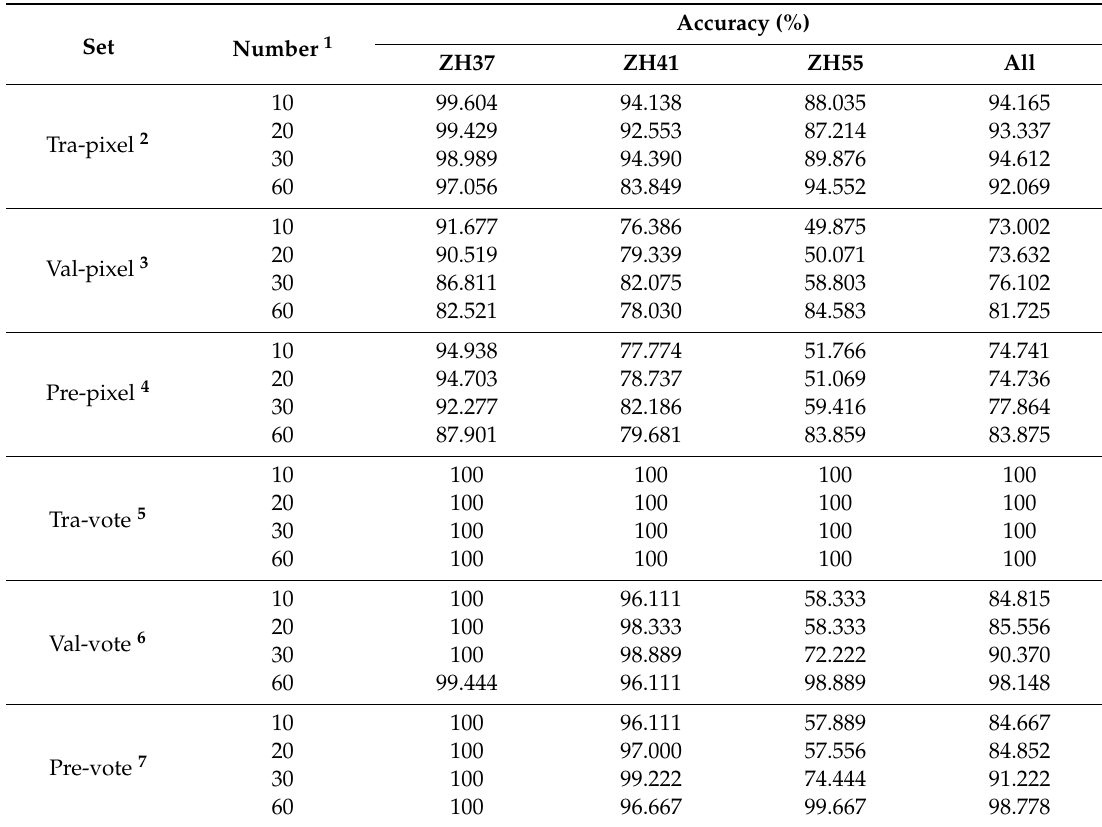
Table 5. The results of pixel-wise CNN models and the vote results of each soybean variety.